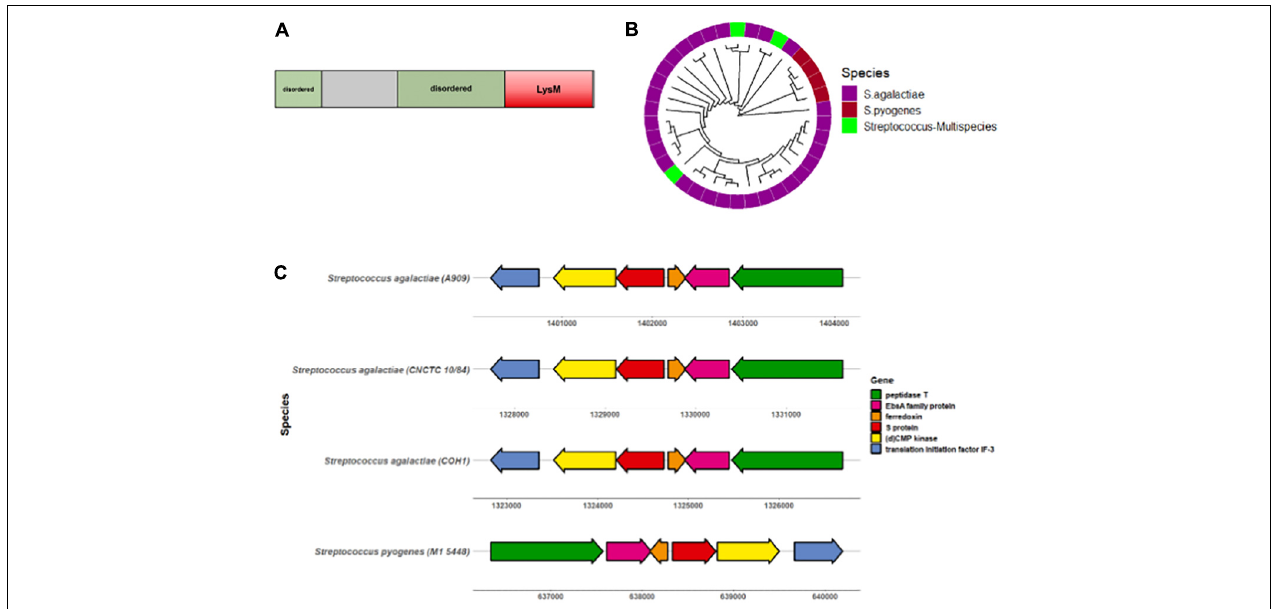
FIGURE 2 | S protein is conserved amongst GBS serotypes. (A) Diagram showing GBS S protein functional protein domains. (B) Circular dendrogram showing phylogeny of S protein homologs in Streptococcus genus acquired from PSI-BLAST of the CNCTC 10/84 strain S protein sequence. Sequences with > 60% sequence identity and > 70% query coverage for used for phylogeny analysis. (C) Gene locus location of GBS S protein ( ess ) and surrounding genes. ( Figure 1B ). As hypothesized, (cid:49) ess associated more readily